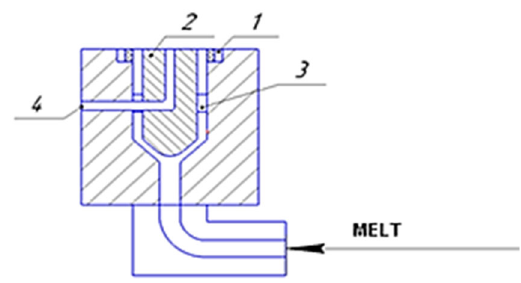
Figure 8. Diagram of an angular angle head: 1—adjustable head jaws; 2—mandrel; 3—holder; 4—channel for air supply for sleeve inflation.